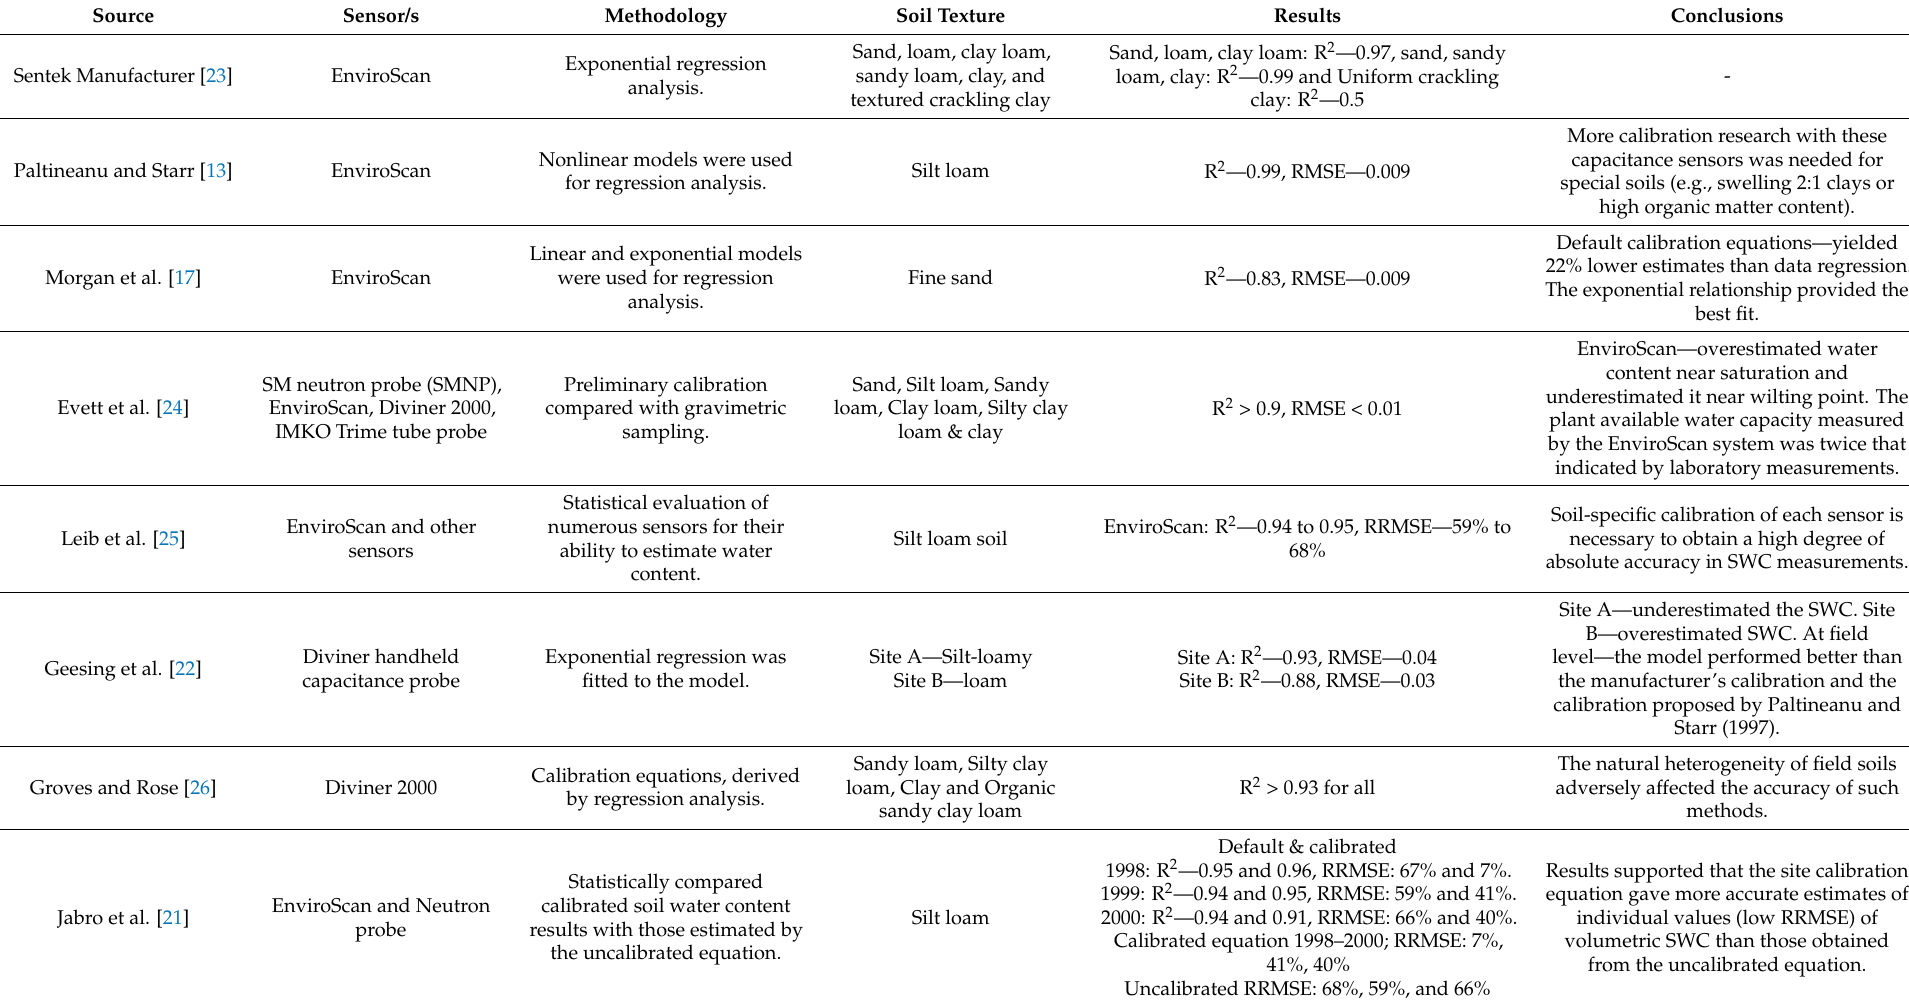
Table 1. Summary of literature on Sentek EnviroScan and Diviner 2000 probes and other various capacitance